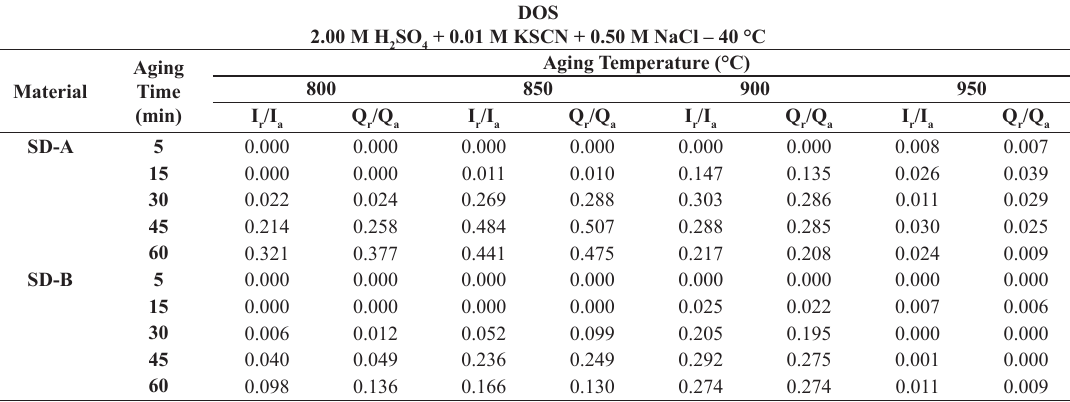
Table 4. I /I and Q /Q values obtained for SD-A and SD-B in 2.00 M H r a r a